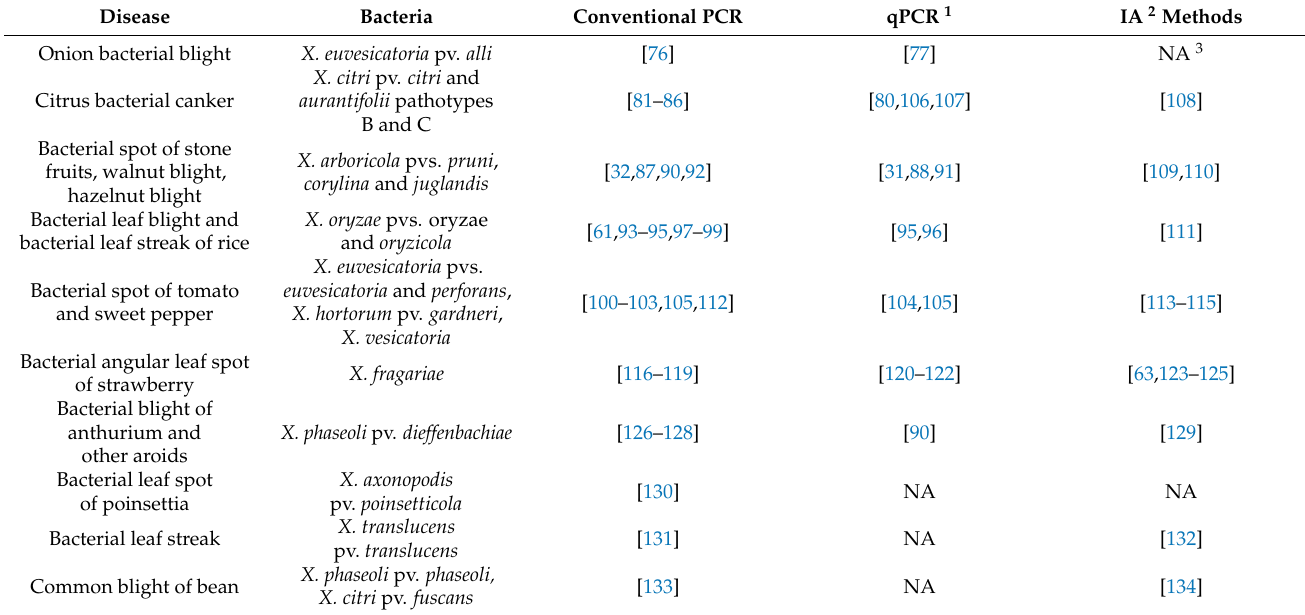
Table 2. Main protocols described for regulated xanthomonads based on amplification of specific target DNAs.